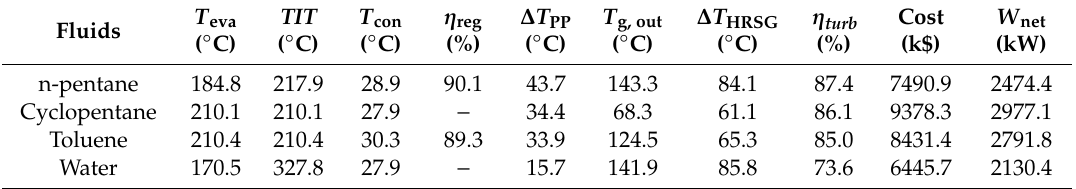
Table 5. Optimized decision variables and system performance of the SRC and ORC systems.